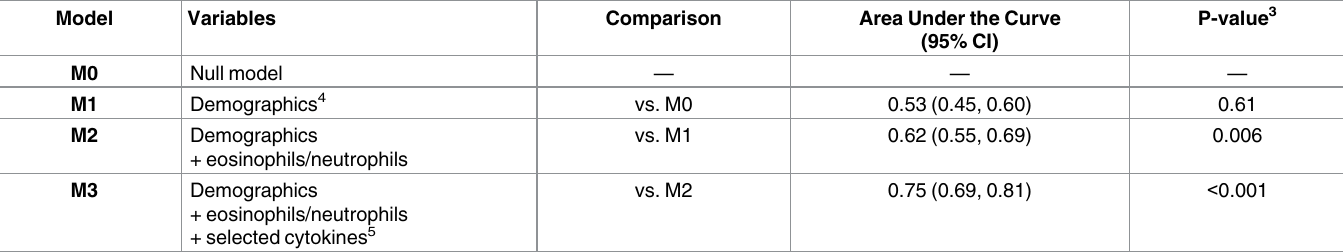
Table 5. In addition to demographics and blood eosinophils and neutrophils, serum cytokines strengthen the characterization of difficult-to-con- trol asthma. 1,2 .